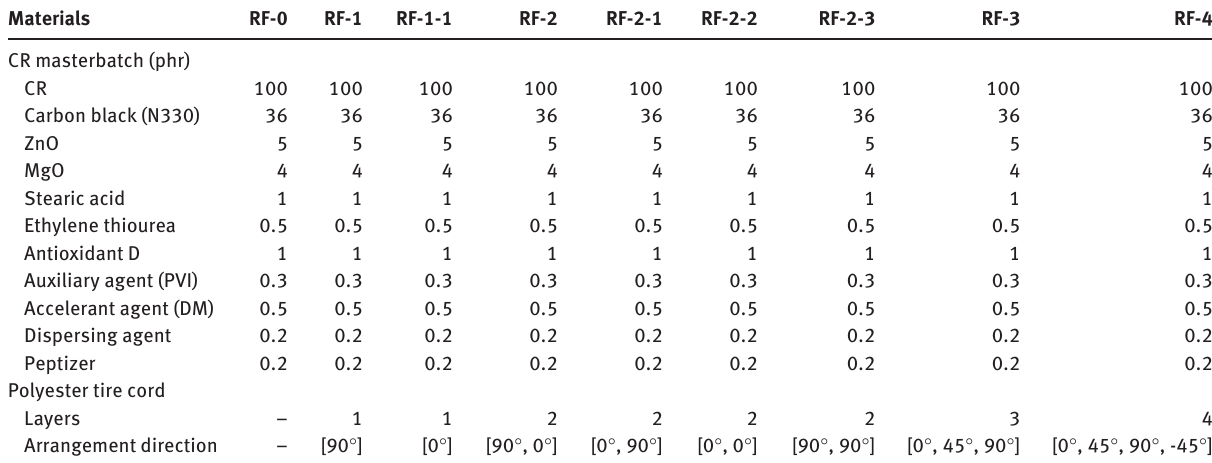
Table 1 Compositions of CR masterbatch and polyester tire cord.